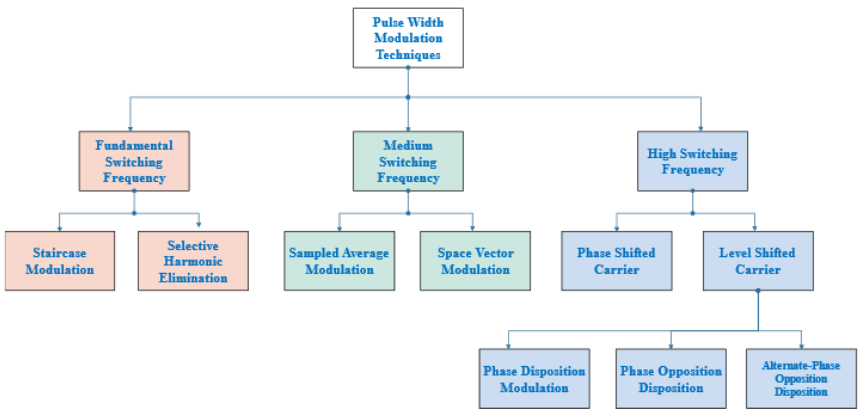
Figure 8. General pulse width modulation classification based on switching frequency.